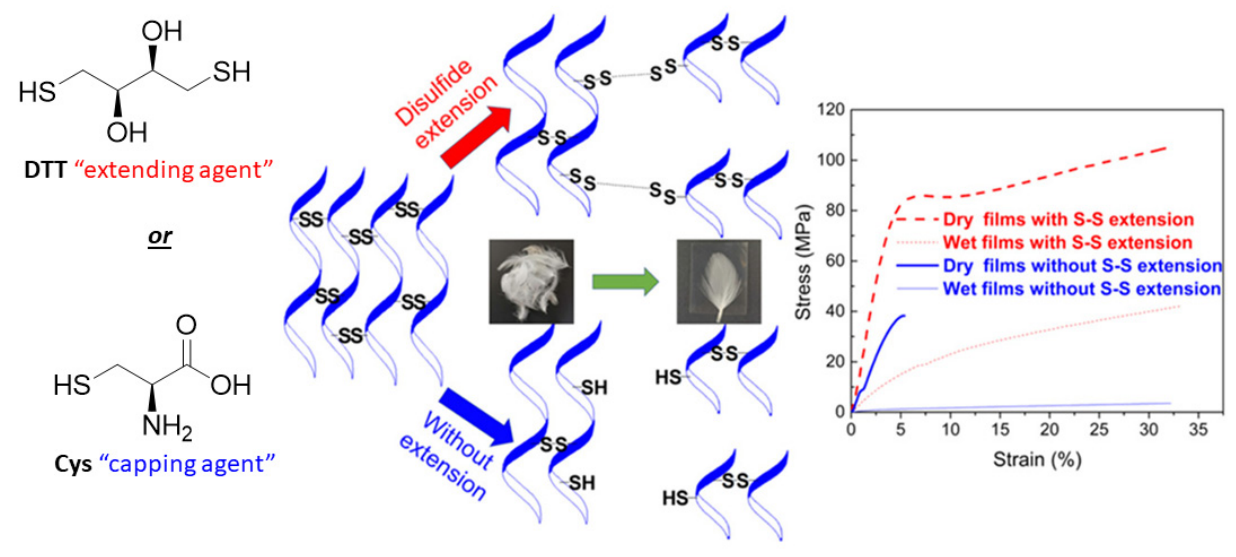
Figure 7. Structures of disulfide extenders (in red, DTT) and capping agents (in blue, Cys) that were added to processed keratin to restore disulfide bonds. Adapted with permission from [38]. Copyright (2020) American Chemical Society.